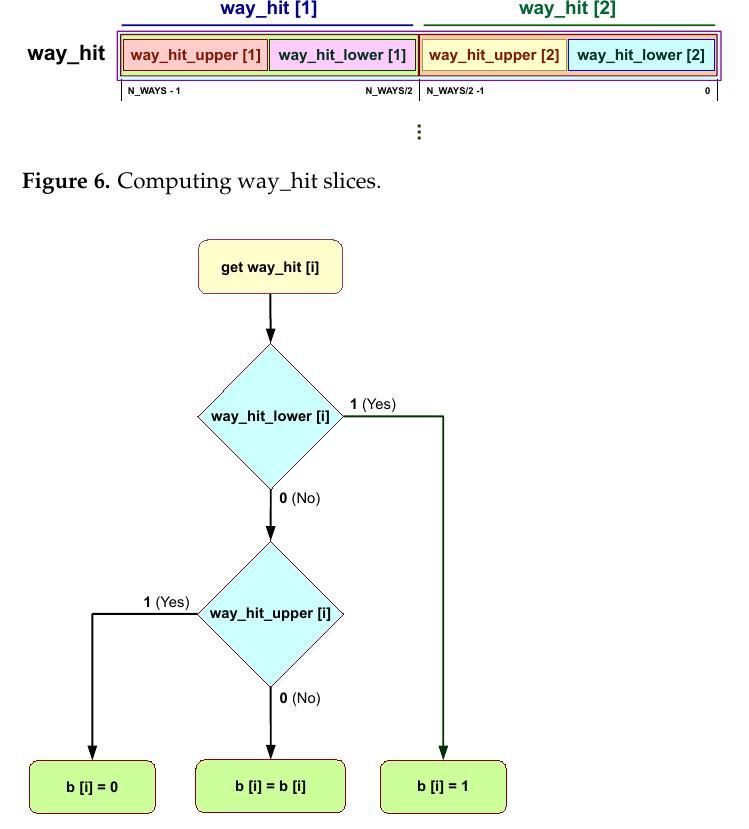
Figure 7. PLRU way